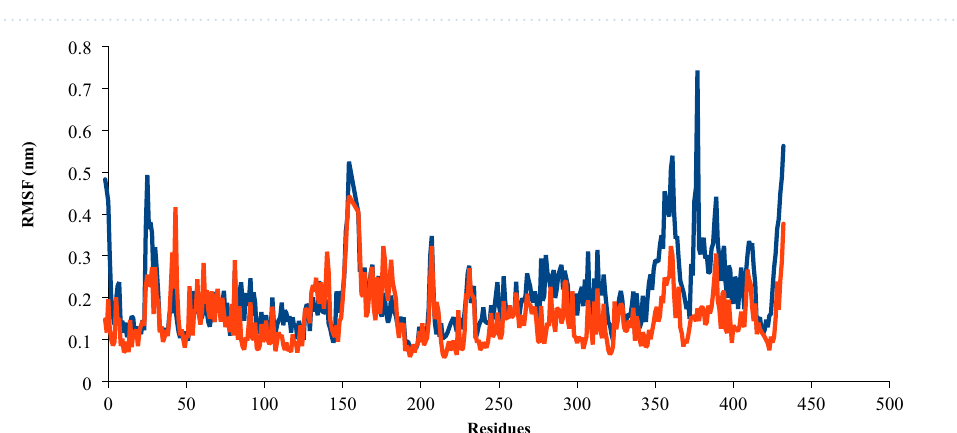
Figure 8. ( a ) RMSD values of DNA in the presence of CNP. ( b ) RMSD values of DNA in the presence of UNK4.